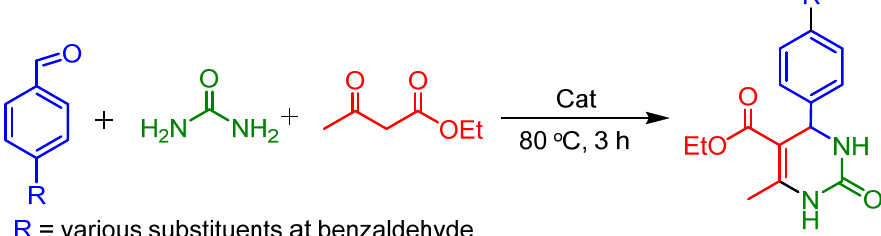
Scheme 2. Scheme for multicomponent Biginelli reaction for the synthesis of 3,4-dihydropyrimidin- 2(1 H )-one (DHPM).